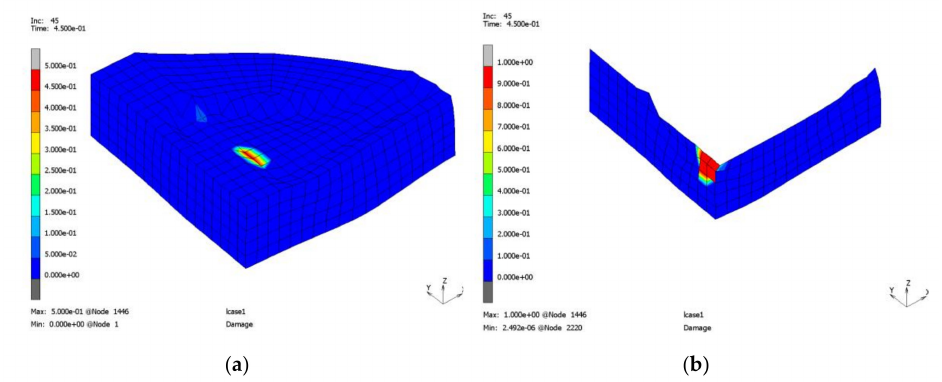
Figure 9. Forming process using the original geometry; whole geometry ( a ) and joining zone ( b ): joining zone damage.